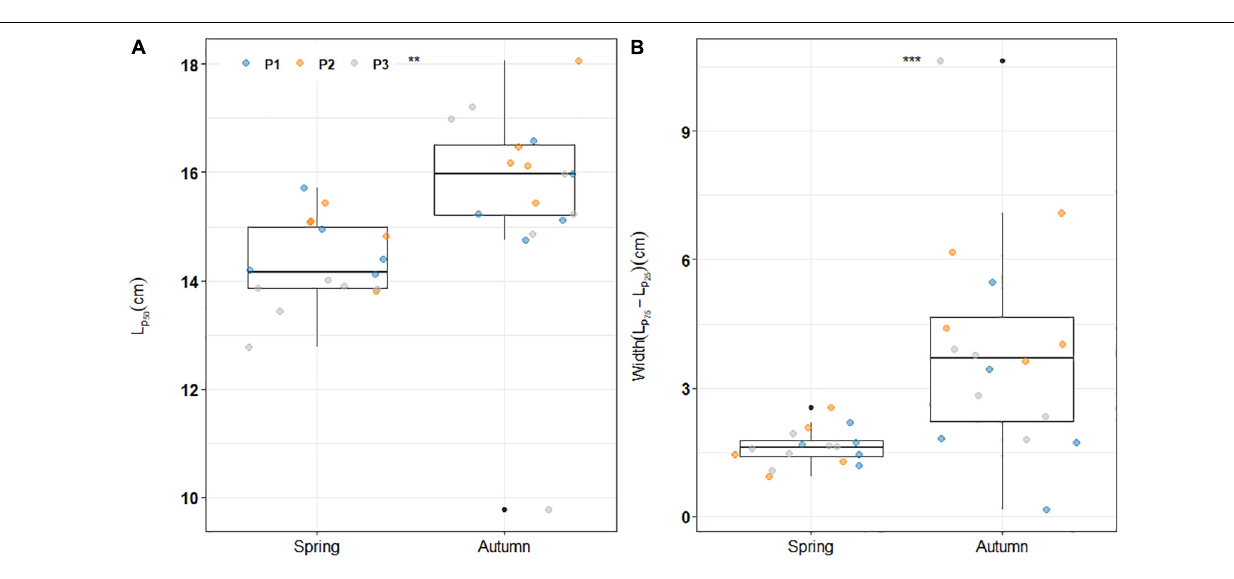
FIGURE 3 | Global distribution of all (A) estimated maturation reaction norm midpoints and (B) corresponding envelope widths (difference between L p for both seasons over the study period. For both panels, stars indicate significant differences between Spring and Autumn in (A) average PMRNs (**) and (B) both variance and average envelope widths (***). P1; P2 and P3 refer to the three identified period in Véron et al.